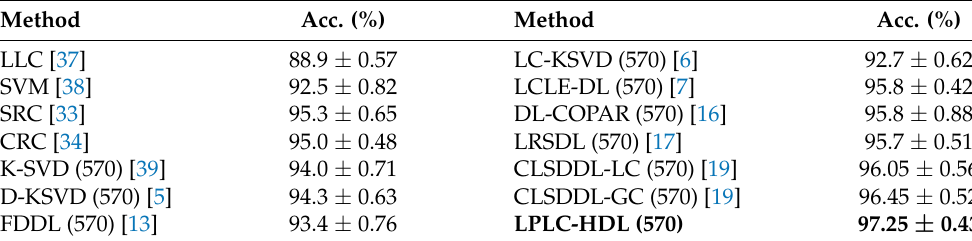
Table 3. The recognition rates (%) on the Extended YaleB face dataset. Method Acc.